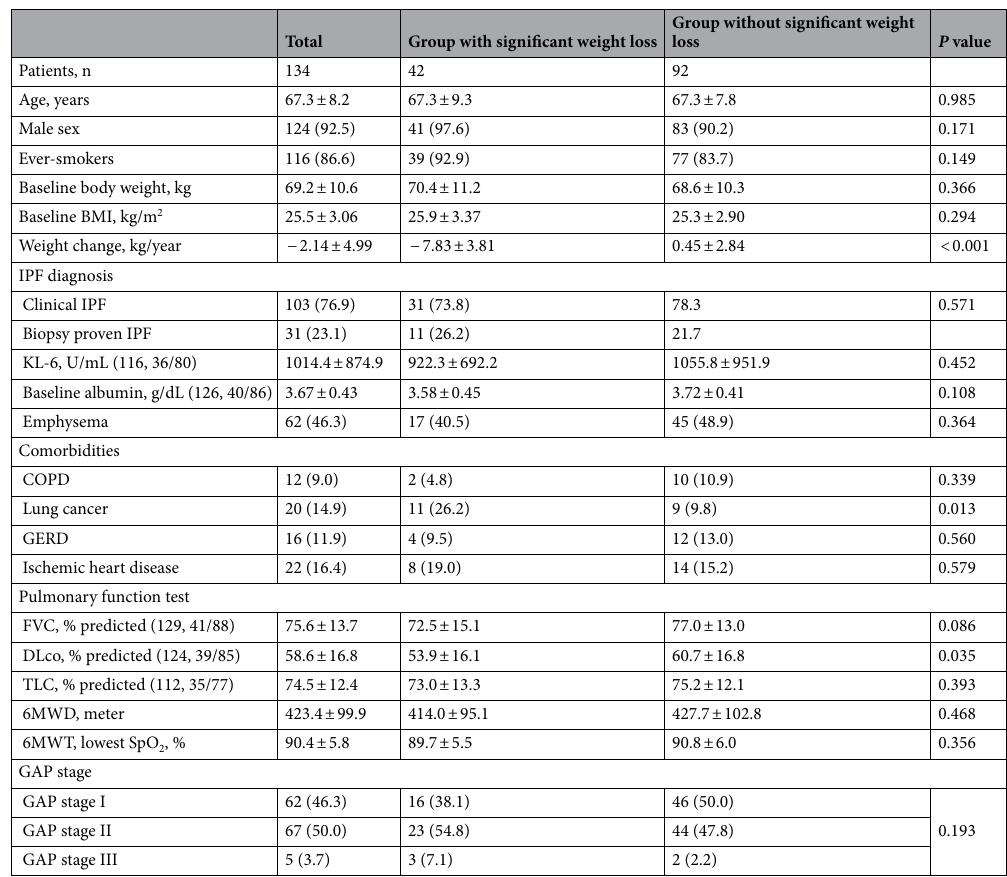
Table 1. Patient characteristics. Data presented as mean ± standard deviation, median (interquartile range), or n (%), unless otherwise indicated. If a variable could not be measured in all patients, the number of patients for whom the variable was measured in total population and each group is indicated in parentheses next to the variables in the first column. BMI body mass index, COPD chronic pulmonary obstructive disease, GERD